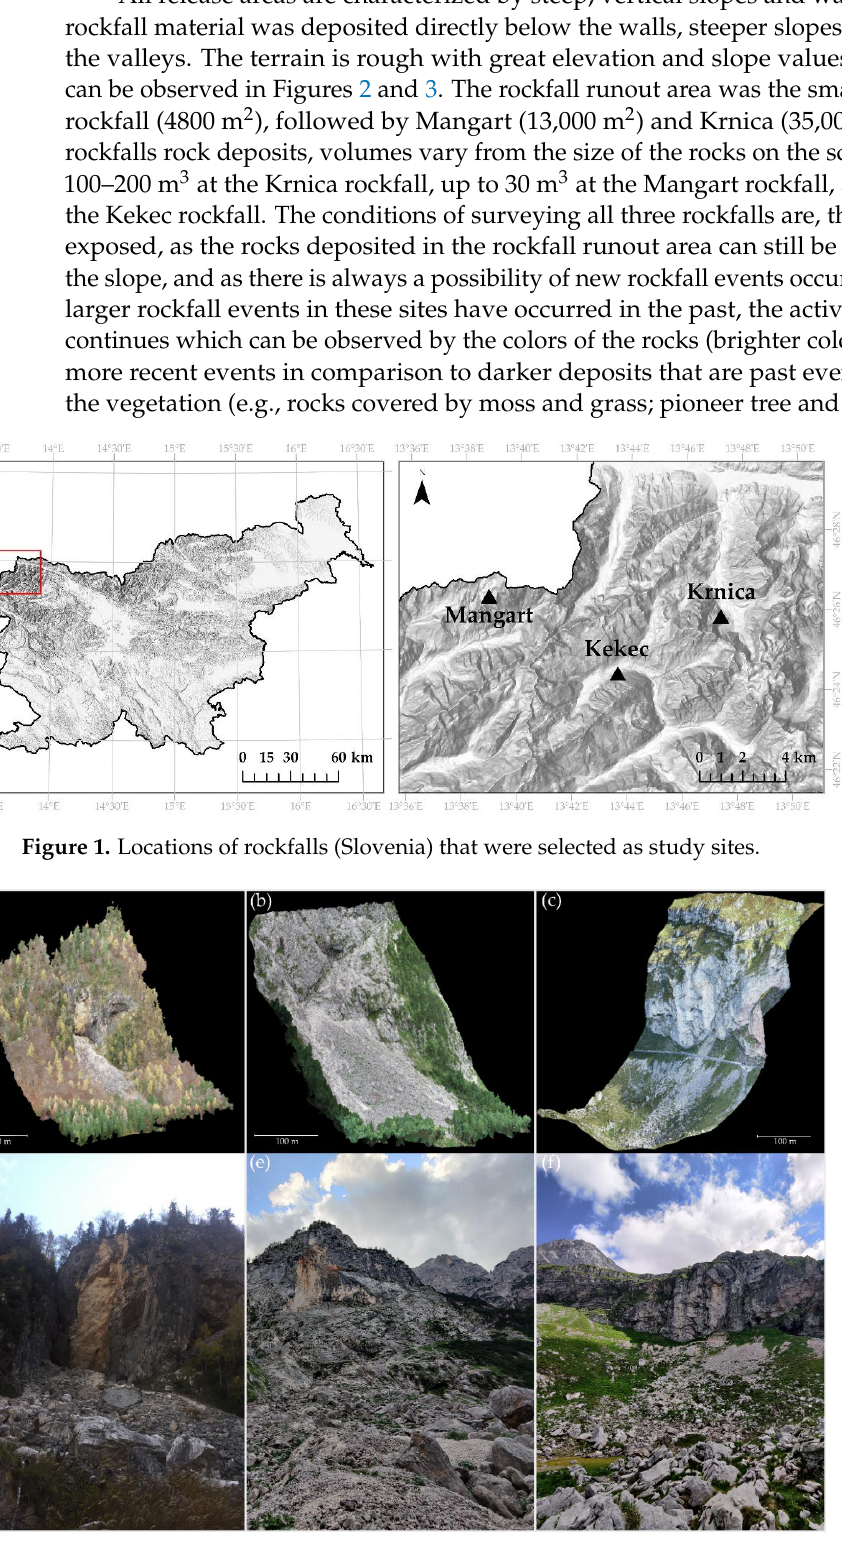
Figure 2. Three-dimensional models of rockfalls ( a – c ) and photos from the field ( d – f ) of Kekec ( a , d ), Krnica ( b , e ), and Mangart ( c , f ).